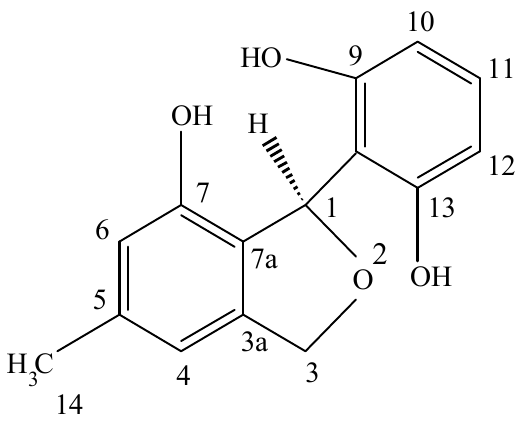
Figure 4. The structure of pestacin.